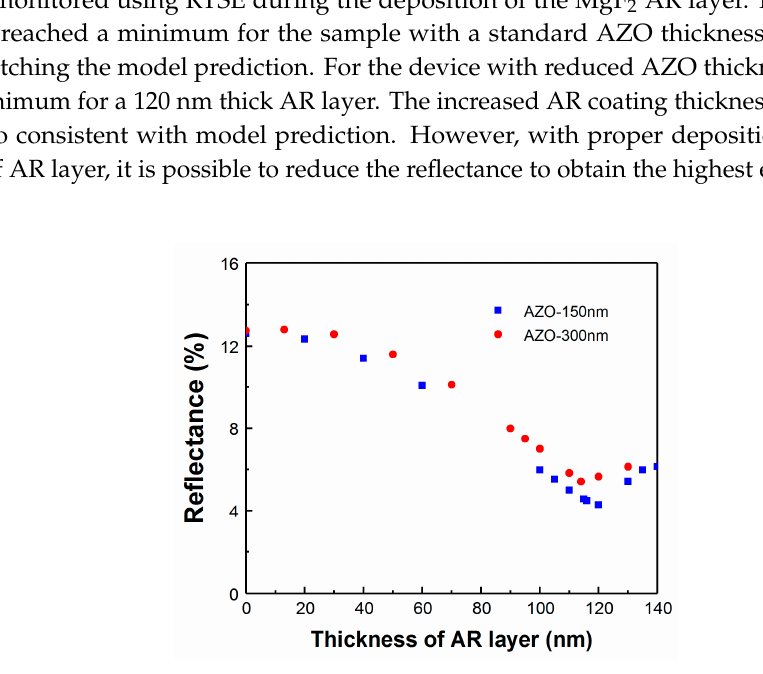
( b ) Figure 13. ( a ) Simulated QE for varied AZO layer thickness with a fixed 110 nm MgF 2 AR layer. ( b ) Simulated J SC as a function of MgF 2 thickness for various AZO layer thickness. As shown in Figure 13, J SC is influenced by the reduction in the thickness of the TCO layer. There